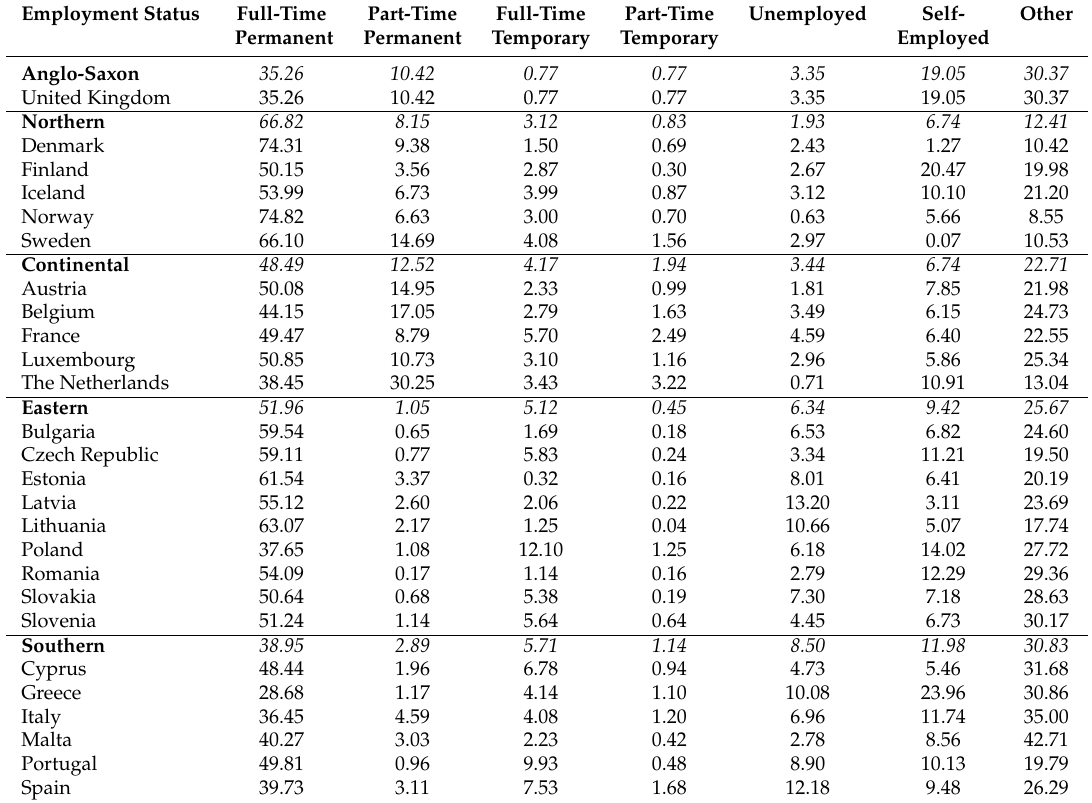
Table 4. Conditional percentage distribution of employment status given country and welfare